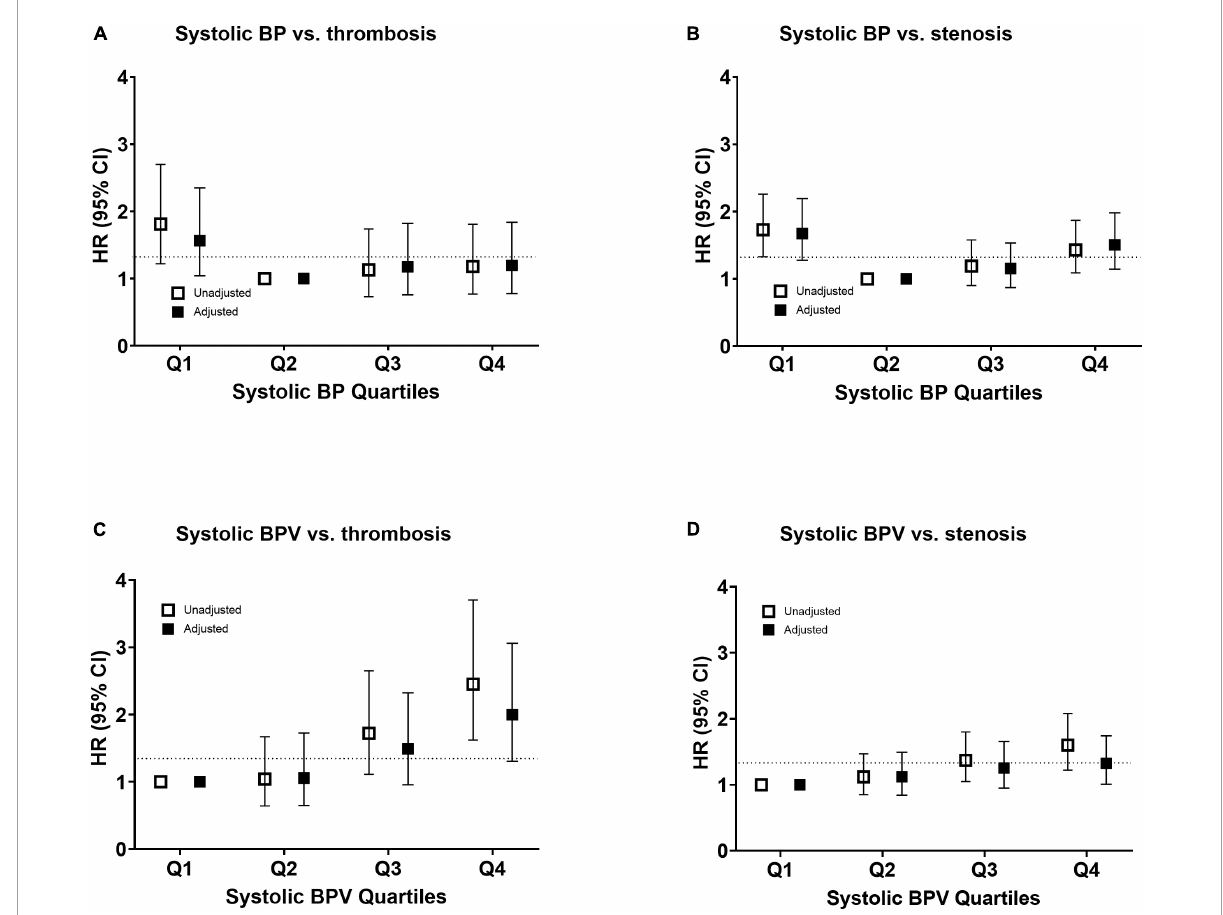
FIGURE3 Risk of vascular access outcomes by systolic blood pressure and variability. Unadjusted and adjusted hazard ratio of thrombosis (A,C) and stenosis (B,D) events by quantiles of mean systolic blood pressure in panels (A,B) and systolic blood pressure variability in panels (C,D) . The risk was adjusted for age, sex, and all the baseline factors with a p -value < 0.1 in the univariate Cox regression analysis. The squares indicate the hazard ratio and the error bars indicate 95% confidence intervals. CI, confidence interval; HR, hazard ratio; SBP, systolic blood pressure; and SBPV, systolic blood pressure